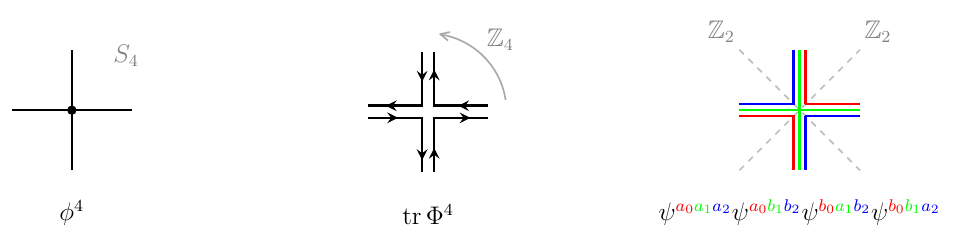
Figure 3. Left: the symmetry group of (cid:30) 4 theory is the symmetric group S 4 . Middle: the symmetry group of tr (cid:8) 4 theory is the cyclic group Z 4 . Right: the symmetry group of the quartic tensor interaction is the Klein group Z 2 2